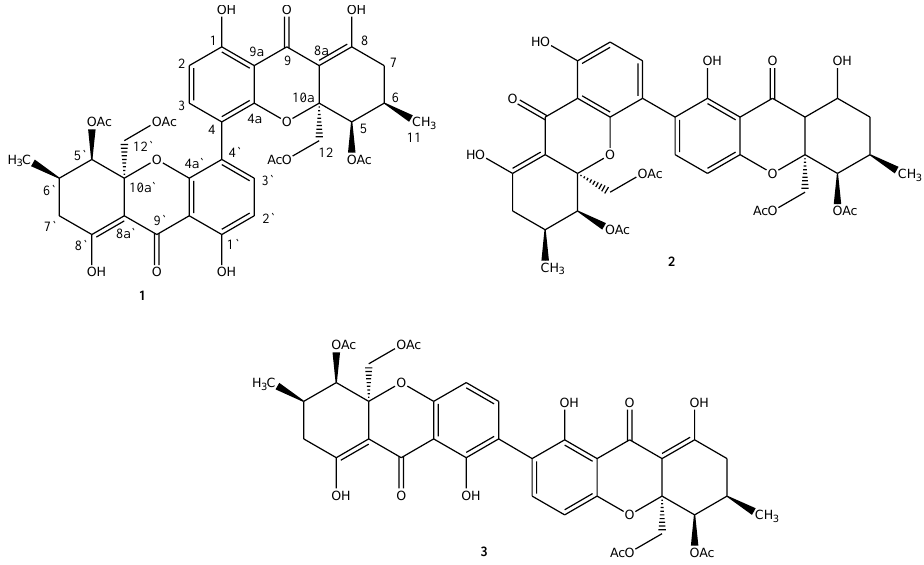
Figure 1. Dimeric xanthones isolated from Paecilomyces sp. EJC01.1.